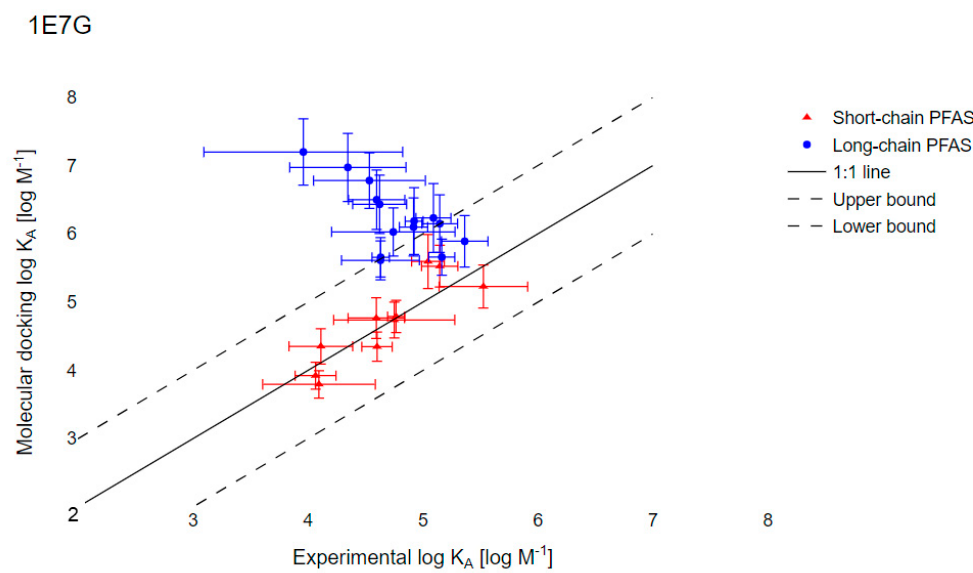
Figure 3. Comparison of experimental log K A with results from molecular simulations with the HSA crystal structure 1E7G. Solid black lines represent the 1:1 line; dotted lines represent one log unit higher or lower. Error bars reflect one geometric